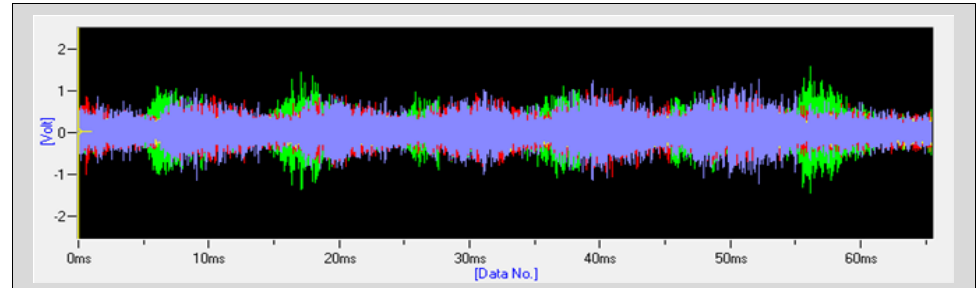
Figure 6. The comparation PD signal waveform with AE1–AE4.